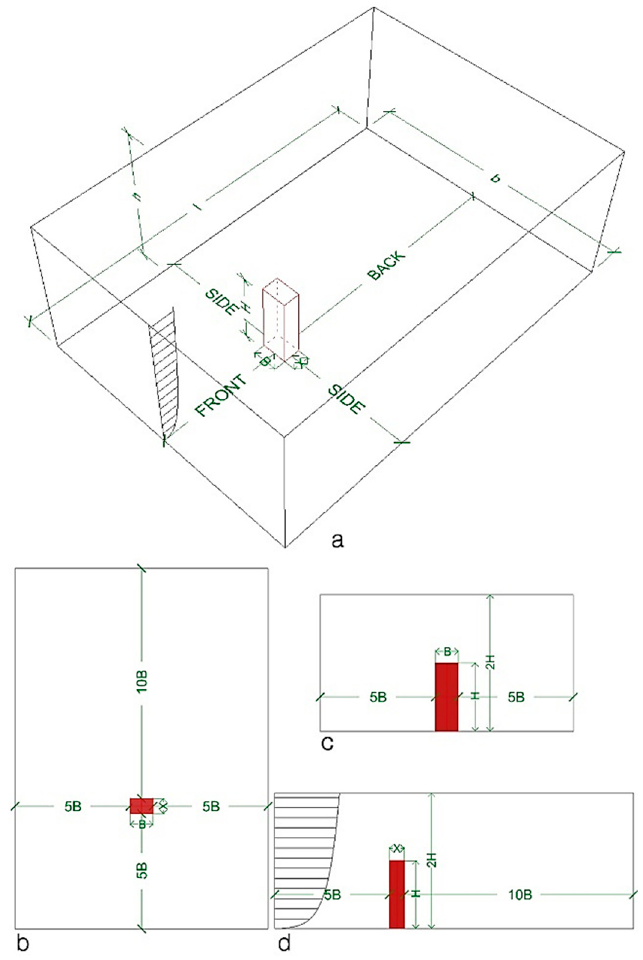
Figure 1. ( a ) Computational domain and location of the building; ( b ) top view; ( c ) front view; ( d ) side view.